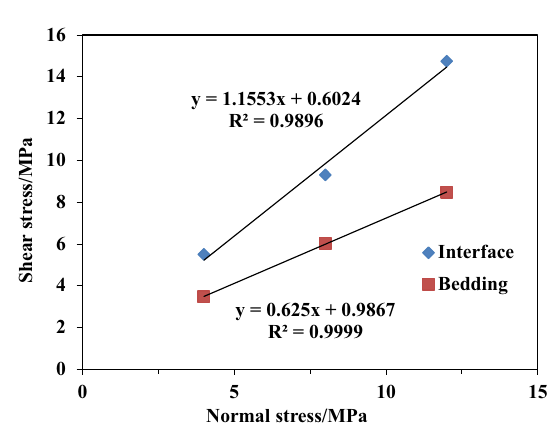
y = 1.1553x + 0.6024 R² = 0.9896